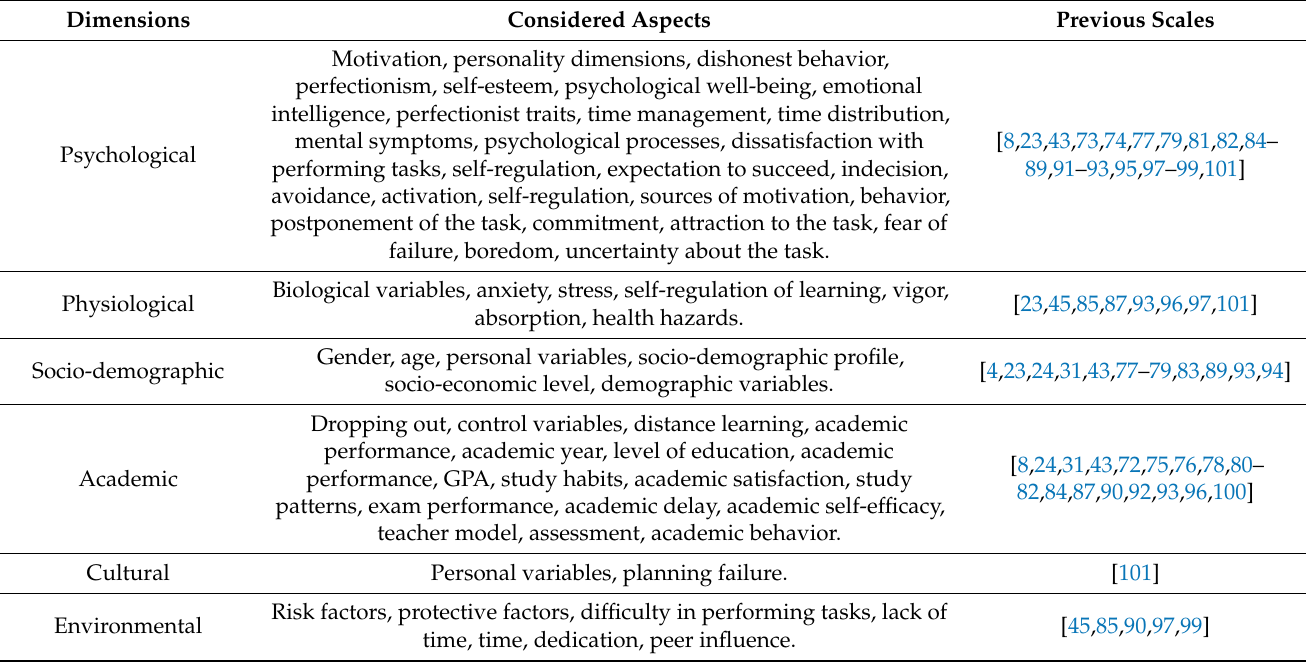
Table 2. Proposal for a Theoretical Model of Procrastination in University Students.